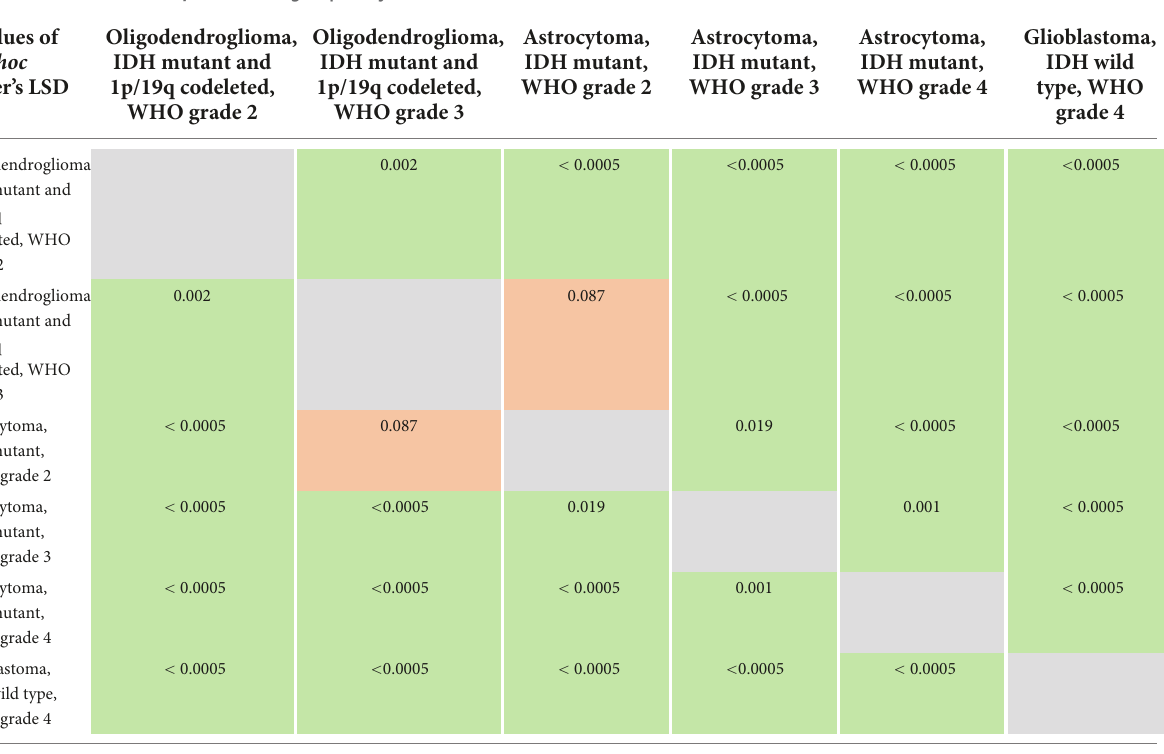
TABLE 2 Detailed results of post hoc subgroup